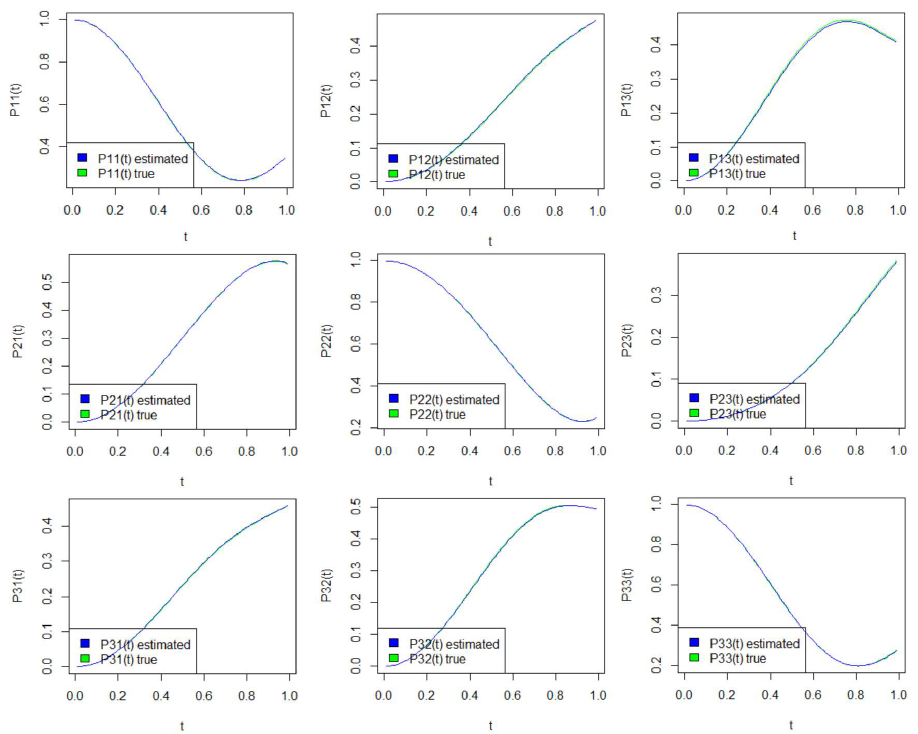
Figure 1. Real and estimated semi-Markov transition probabilities in the case of uncensored